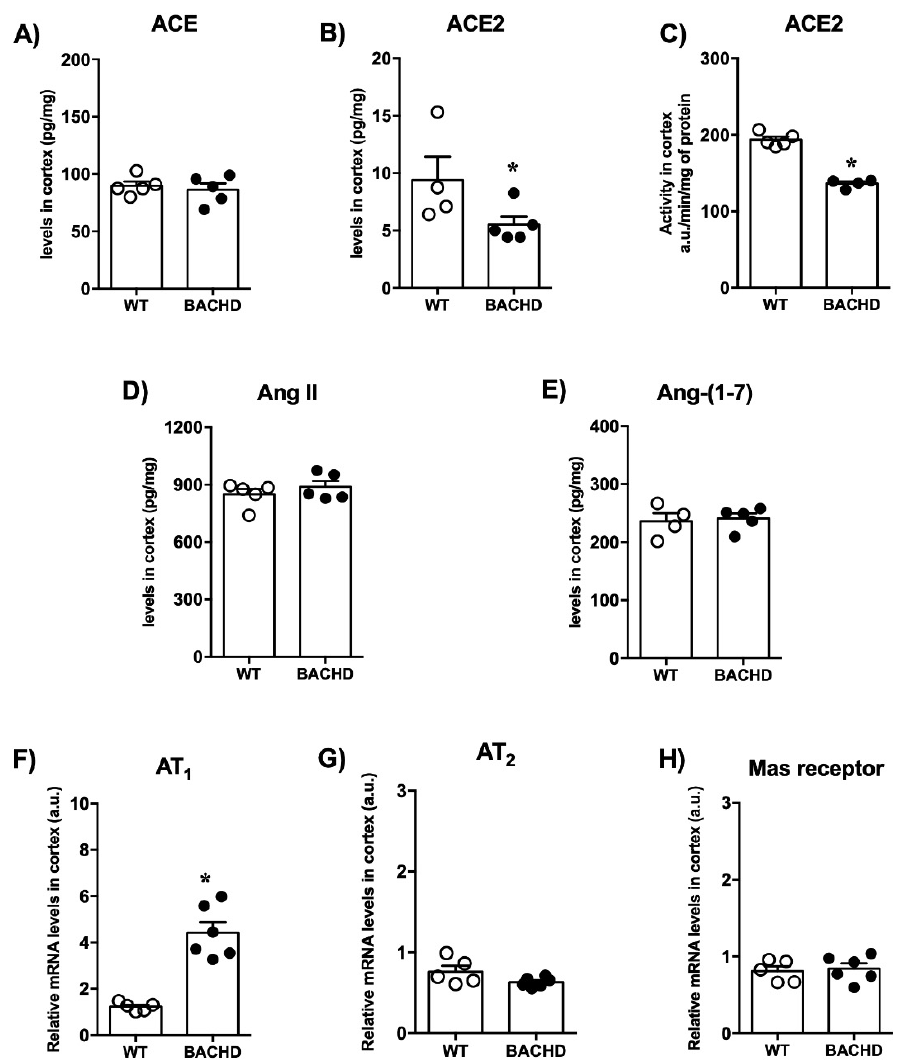
Figure 4. RAS components’ levels in the cerebral prefrontal cortex of BACHD and WT mice. ( A ) ACE, ( B ) ACE2 levels, ( C ) ACE2 activity, ( D ) Ang II levels, ( E ) Ang-(1-7) levels, ( F ) AT 1 receptor expression, ( G ) AT 2 receptor expression, and ( H ) Mas receptor expression in the cerebral cortex of BACHD mice. Results are expressed as mean ± SEM. n = 5–6. * p < 0.05 compared with WT group. The data were analyzed by Student’s t -test.